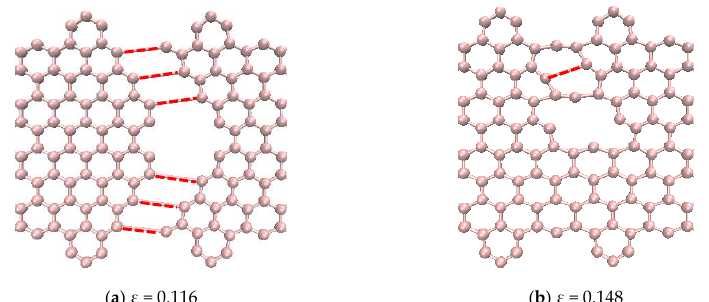
Figure 14. Failure patterns and related atoms and bonds of DV1 and DV2 defects.